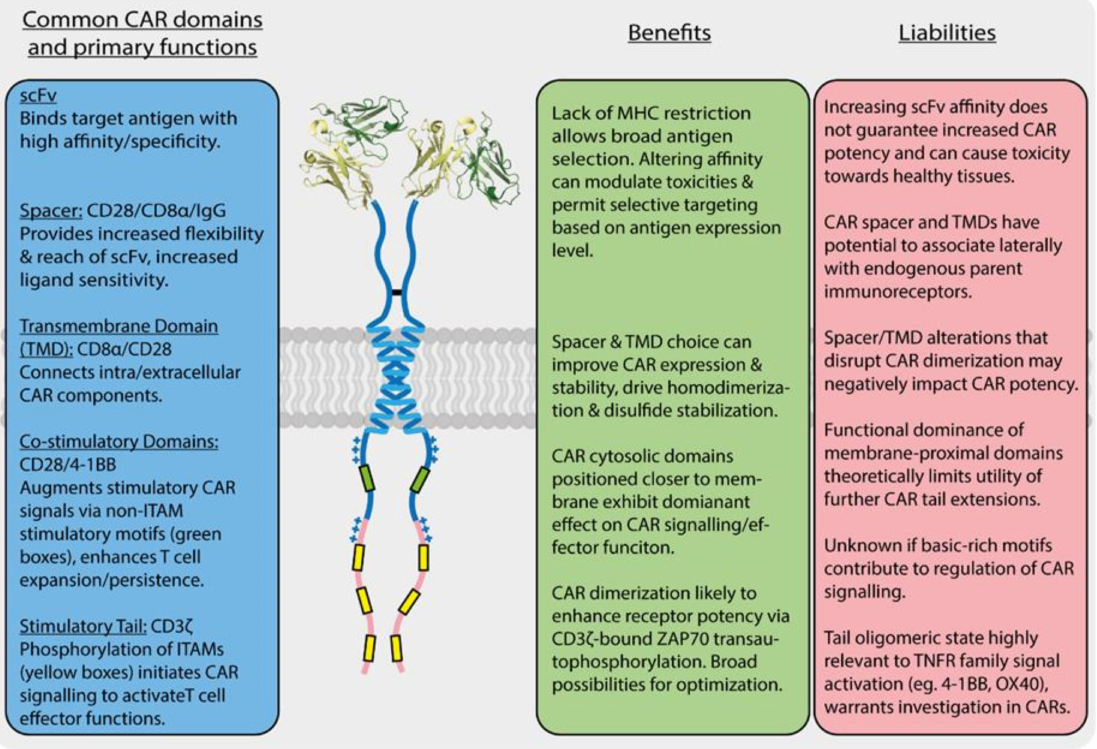
Figure 2. 2nd Generation CAR constructs: the native receptor sequences commonly incorporated and the benefits and liabilities of those domains with regard to CAR function. Structure of the scFv domain is from PDB code